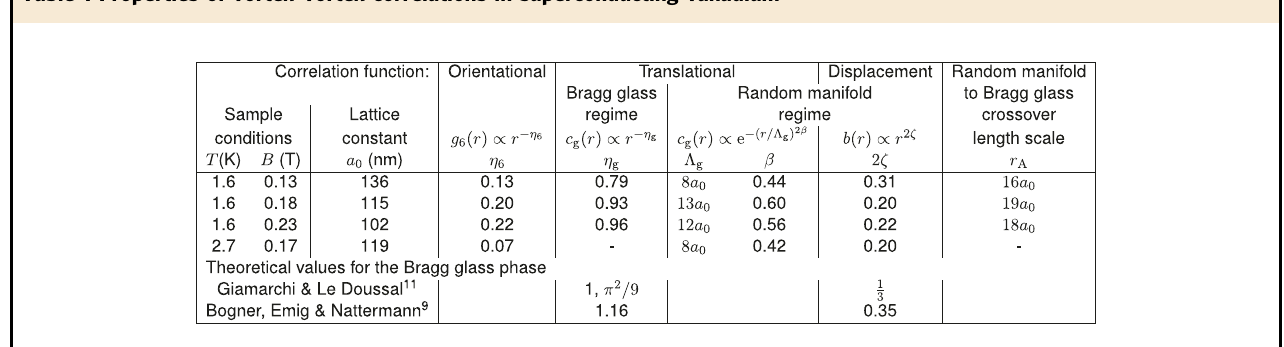
Table 1 Properties of vortex – vortex correlations in superconducting vanadium